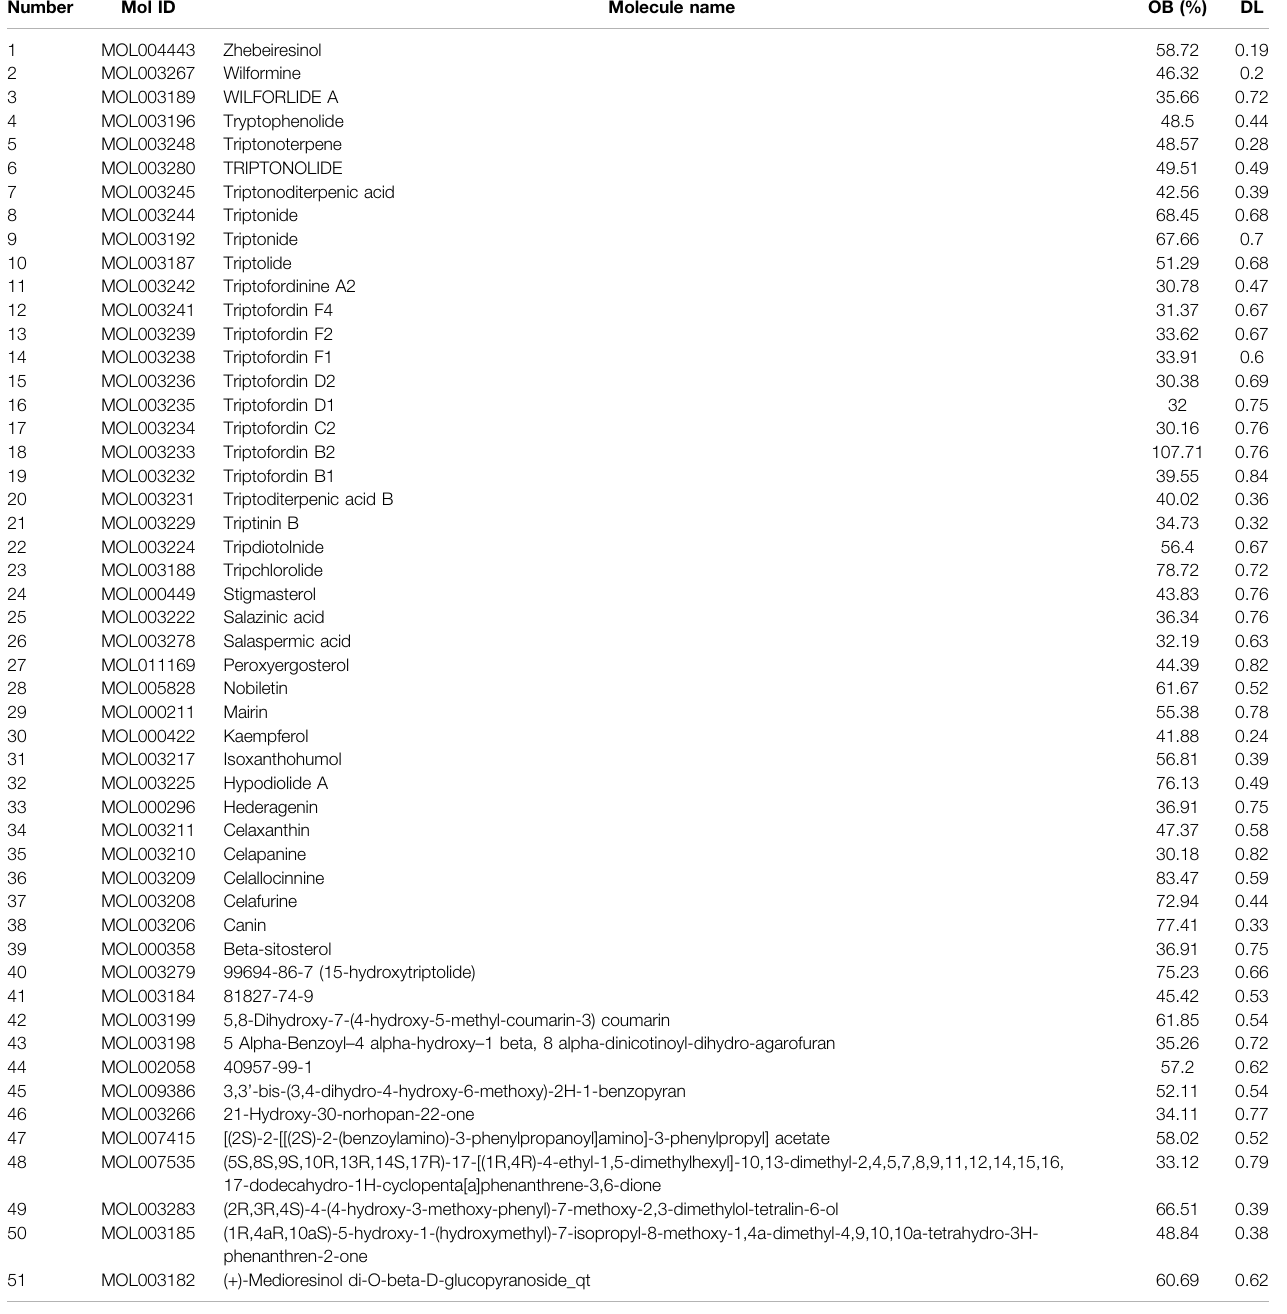
TABLE 1 | Active ingredients of